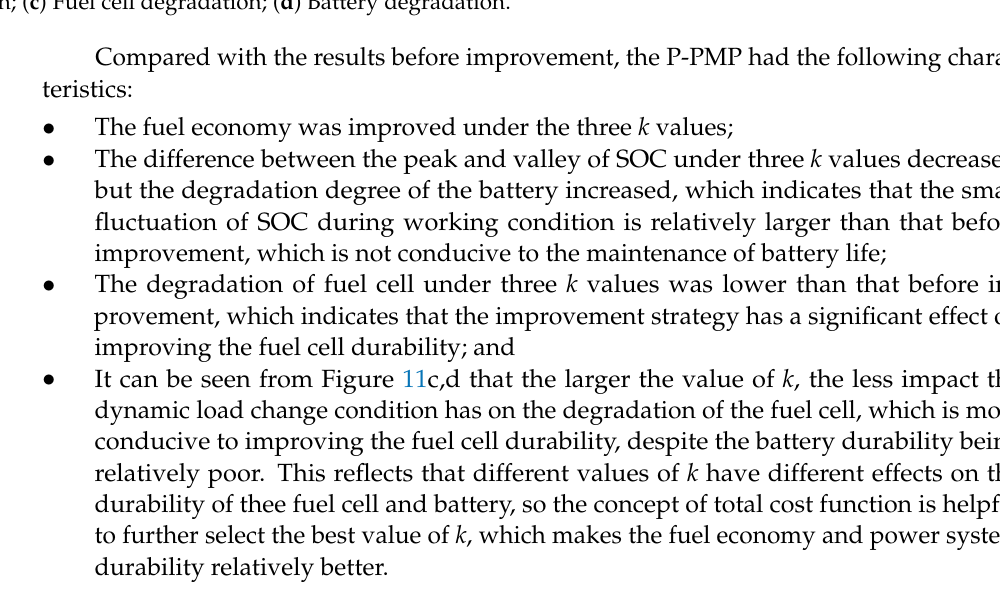
Figure 11. Comparison of fuel economy and power system durability under PMP and P-PMP. ( a ) Total hydrogen consumption; ( b ) SOC fluctuation; ( c ) Fuel cell degradation; ( d ) Battery degradation.